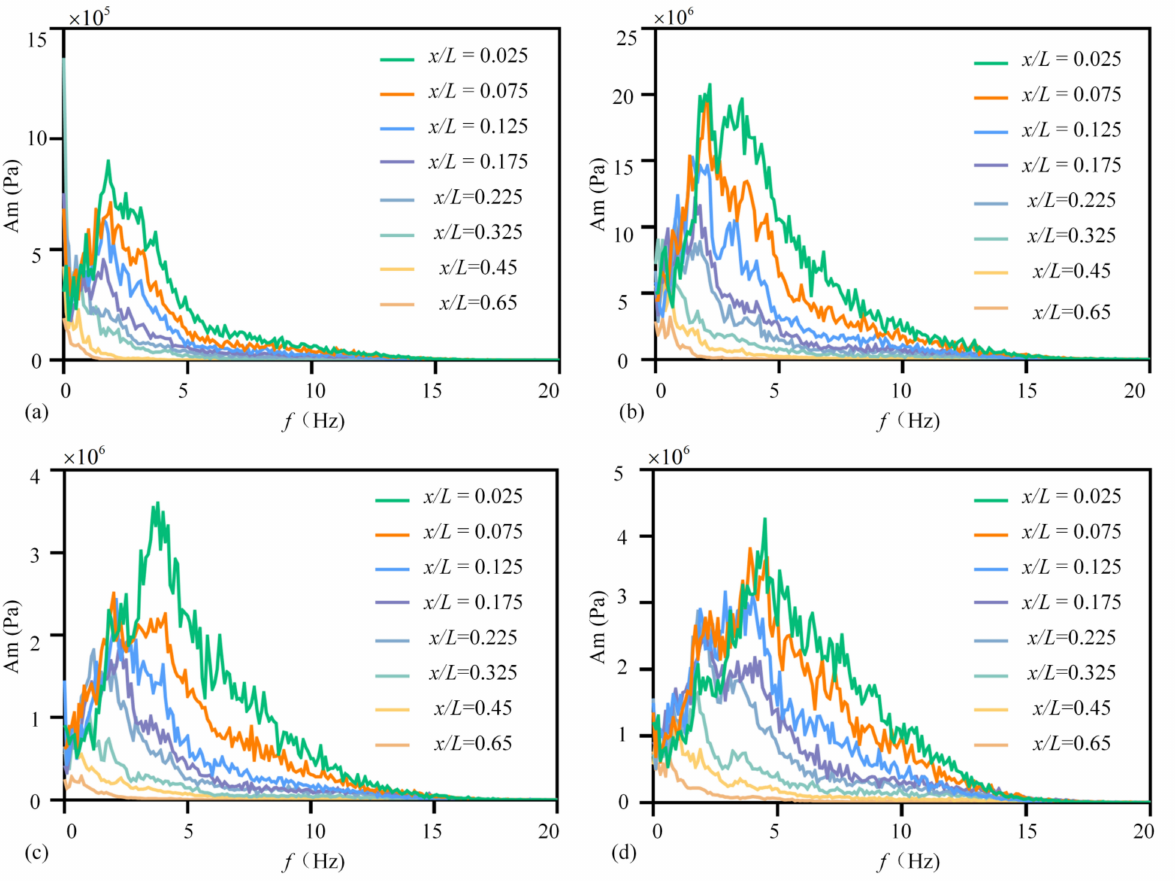
Figure 10. ( a ) k = 0.0134; ( b ) k = 0.0223; ( c ) k = 0.0308; ( d ) k = 0.0403, the Hilbert marginal spectrum of fluctuating pressure at the characteristic point of TP0 (Conventional stilling basin) bottom plate.